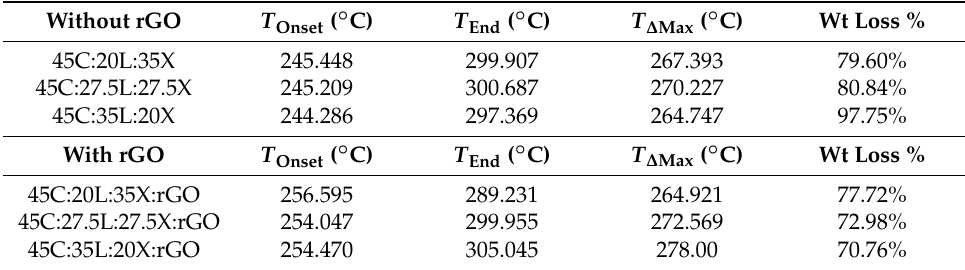
Figure 3. TGA percent weight decomposition analysis for ( A ) pure Samples, ( C ) lignocellulosic blended films and ( E ) lignocellulosic blended films with rGO. TGA derivative percent weight decomposition analysis for ( B ) pure samples, ( D ) lignocellulosic blended films and ( F ) lignocellulosic blended films with rGO. Table 2. TGA decomposition temperatures of blended films without and with rGO components and experimental